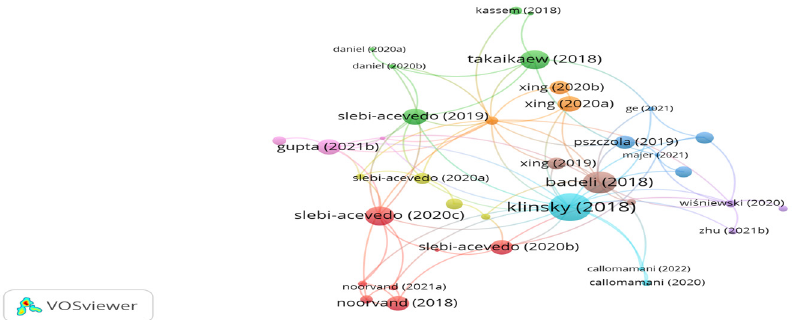
Figure 8. Network visualization of aramid